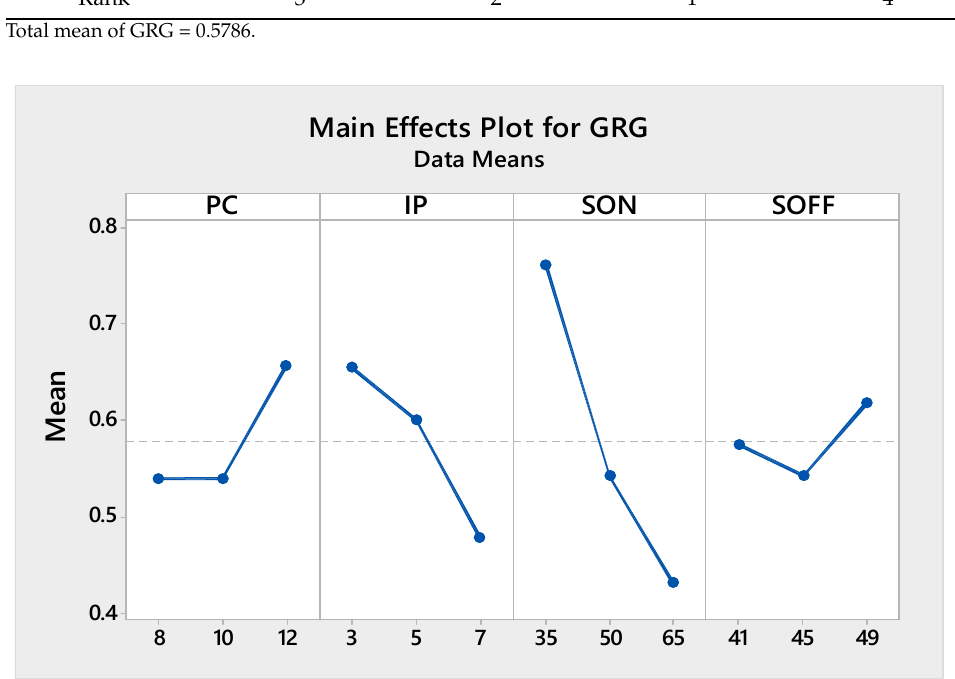
Figure 7. Main Effect Plots for GRG.